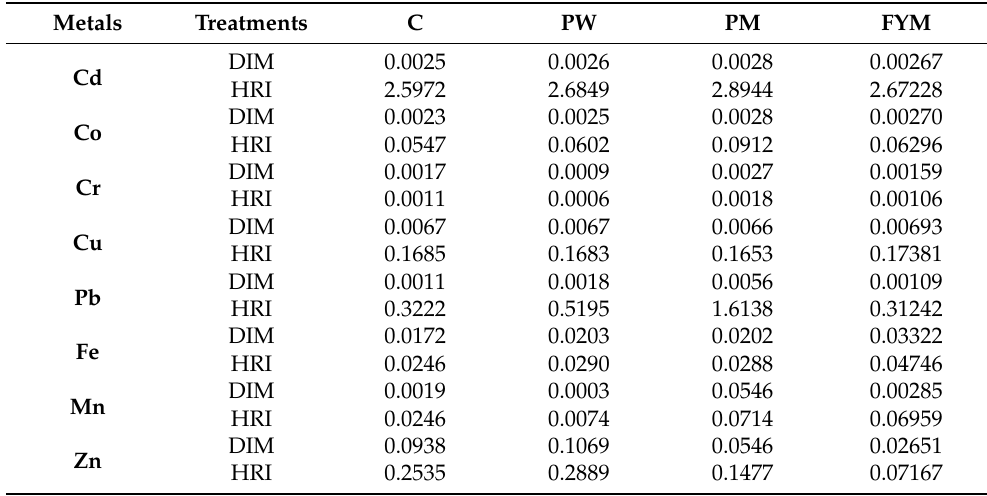
Table 5. Daily intake and health risk index for consumption of A.